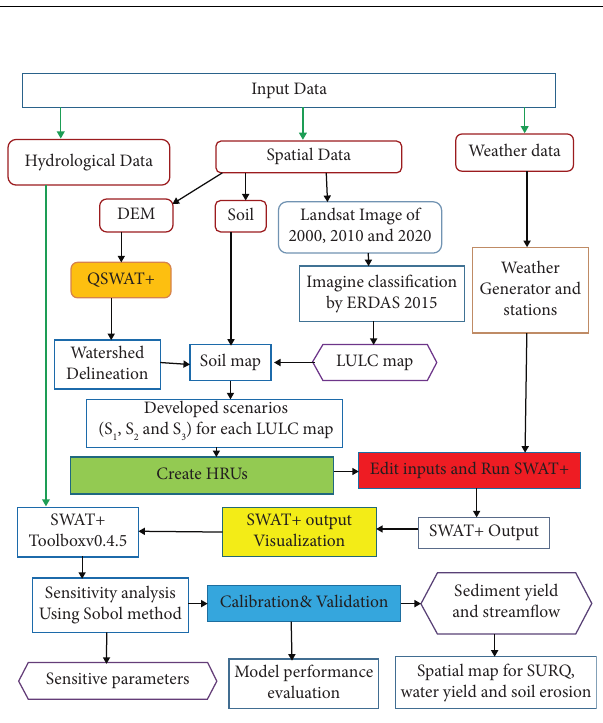
Figure 4: Te overall fow diagram of the